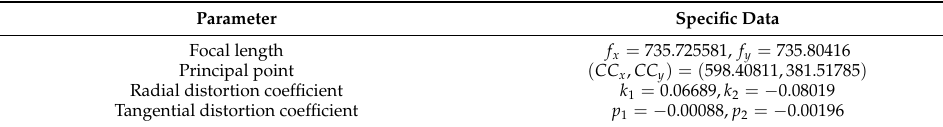
Table 3. Internal parameters of Rmoncam G180